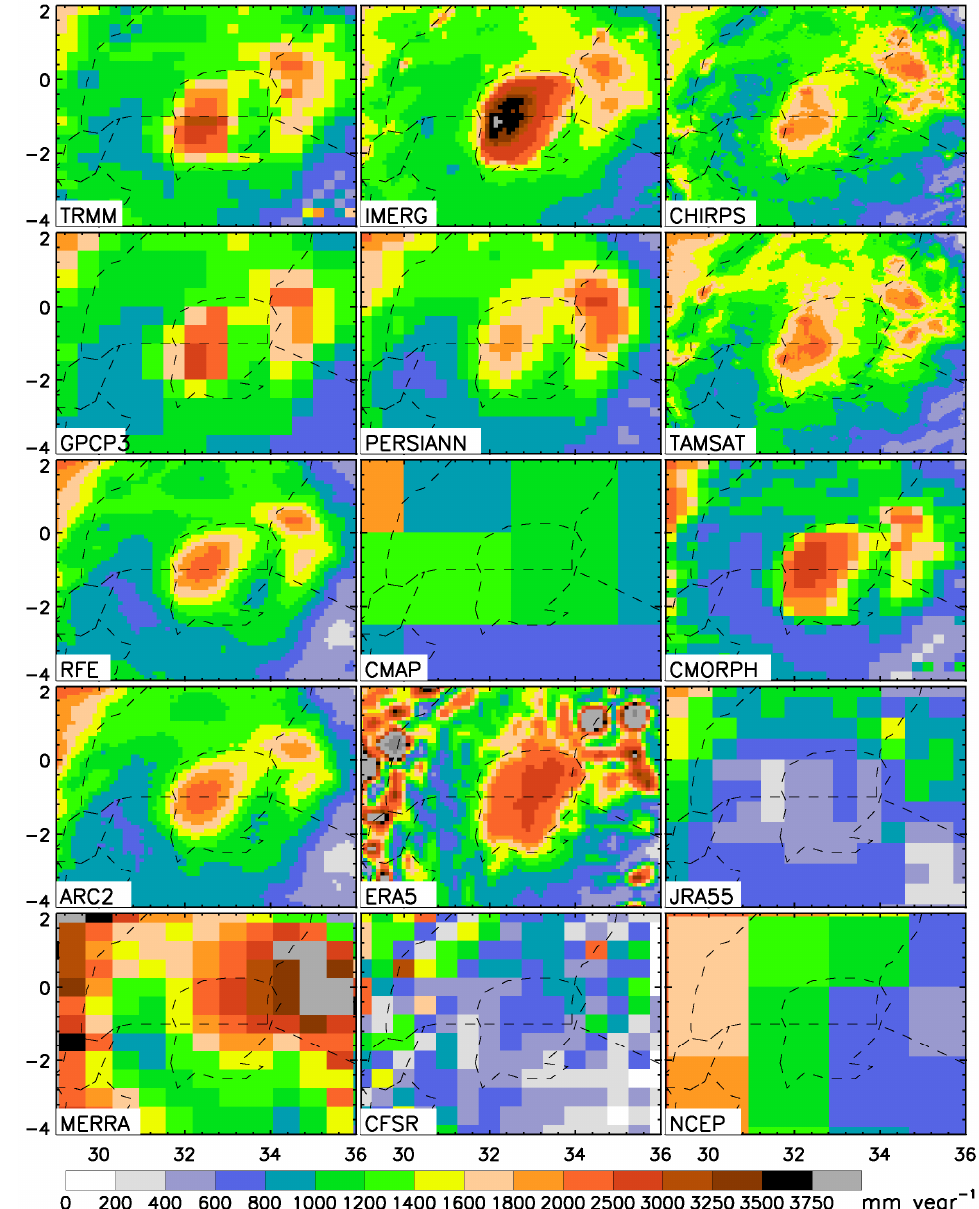
Figure 8. Map of annual rainfall over Lake Victoria and the surrounding region (based on Flohn and Burkhardt